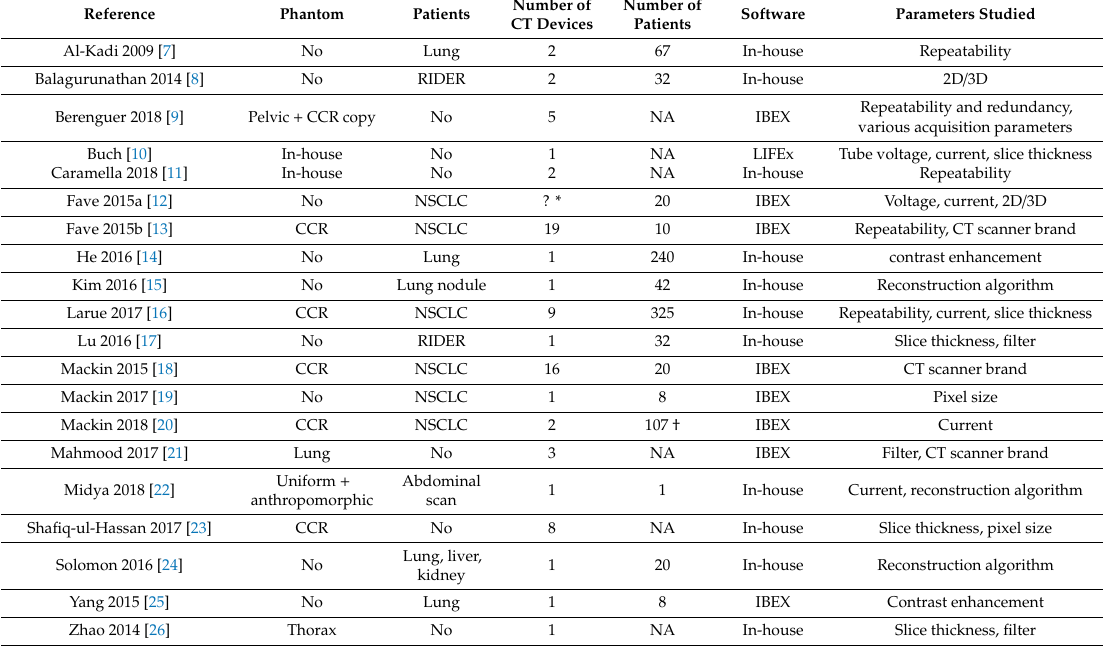
Table 1. Characteristics of selected articles. CCR refers to the credence cartridge radiomics phantom, RIDER to the Reference Image Database to Evaluate Therapy Response and NSCLC to non-small-cell lung carcinoma. * Fave et al. do not indicate the number of CT. † The number is not stated by the authors but the patients come from another study, which included 107